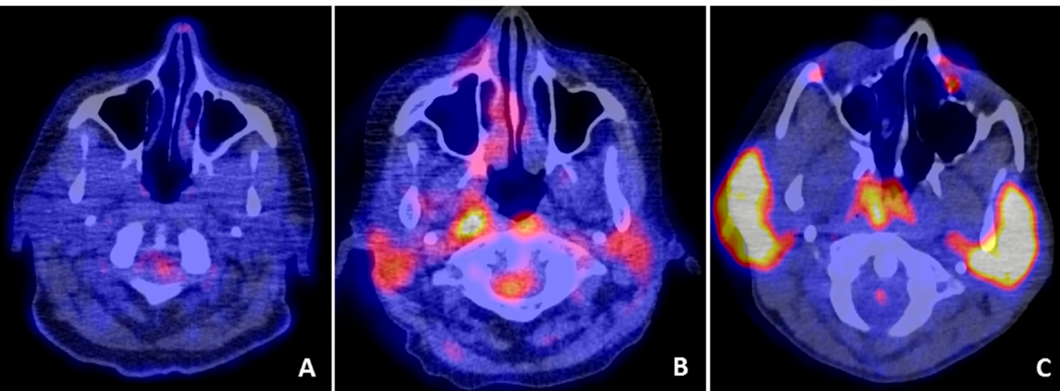
Figure 5. FDG-PET uptake patterns within the parotid glands. FDG-PET / CT showing ( A ) no increased uptake in the parotid glands of a subject without pathology in the head / neck region, ( B ) increased uptake in both parotid glands in a pSS patient, and ( C ) intense uptake in both parotid glands of a pSS patients with histologically confirmed parotid salivary gland MALT